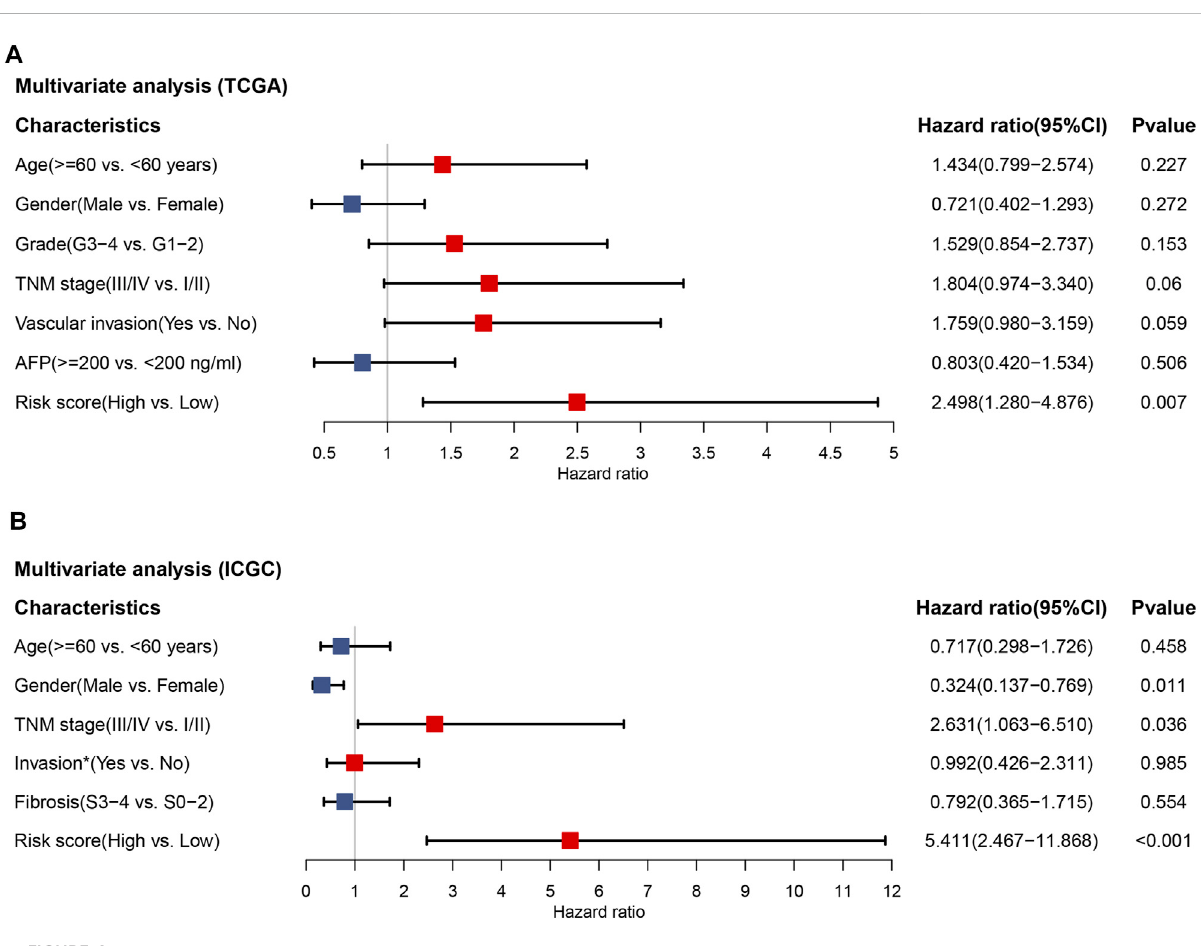
FIGURE 4 The independent prognostic value of the 2-TF signature. Multivariate Cox regression analysis regarding overall survival in the training set of TCGAcohort (A) andthevalidationsetofICGCcohort (B) .*Portalvein,veinorarteryinvasion;TCGA,TheCancerGenomeAtlas;ICGC,International Cancer Genome